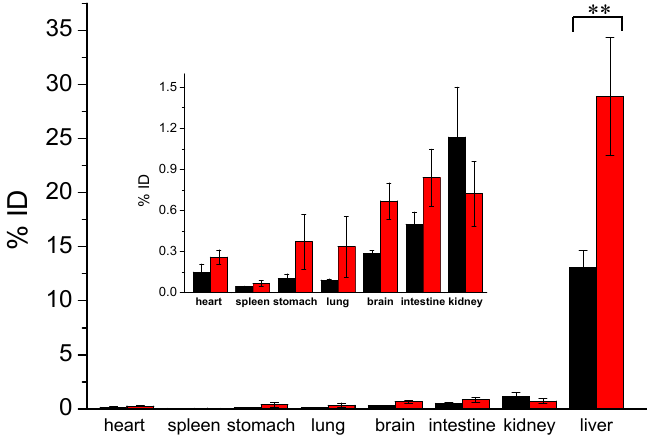
Figure 5. Biodistribution of Cu(I)-GSH and Cu(II)-GSSG complexes in BALB/c mice ( n = 3) 24 h after the tail-vein injection. (“**”, significance of difference).